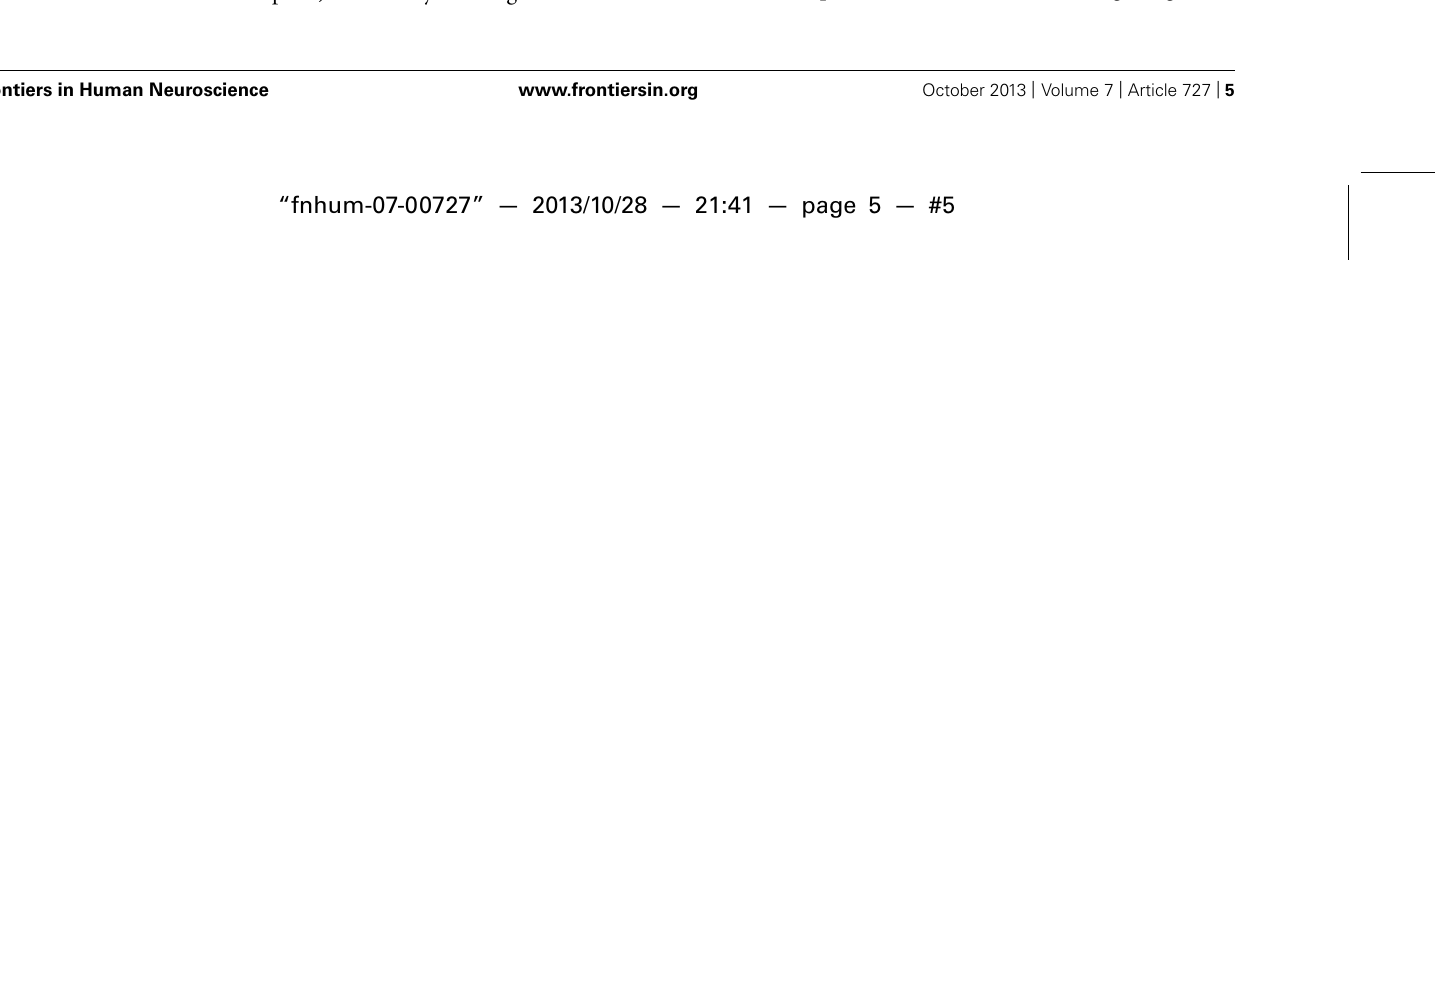
analysis of resting-state fMRI of subjects. SPMs are thresholded at p < 0.05 FDR-corrected and superimposed on a single subject high resolutionT1 image. Color coding (red > yellow) represents t -values ranging from 3 to 25. The x -axis of signal time courses reflects number of fMRI scans; the y -axis represents normalized signal amplitude. First to third row: anterior and posterior (a/p) DMN, anterior and posterior SN, left and right (l/r)